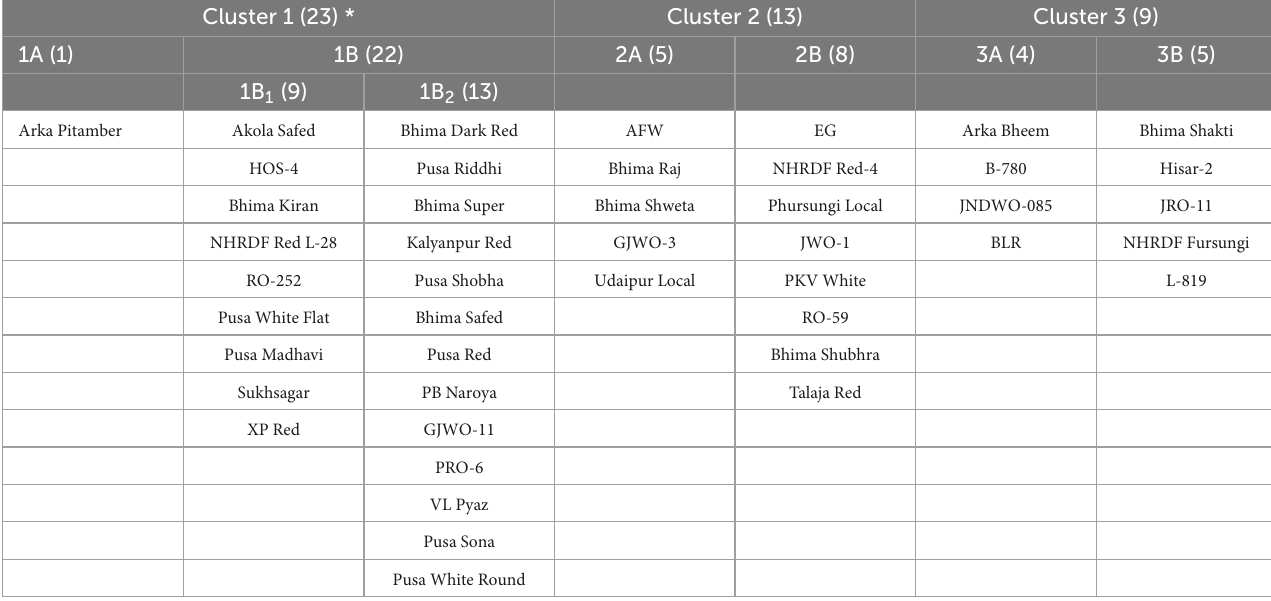
TABLE 4 Cluster analysis of 45 short day Indian onion genotypes for sodium, potassium contents, and potassium/sodium